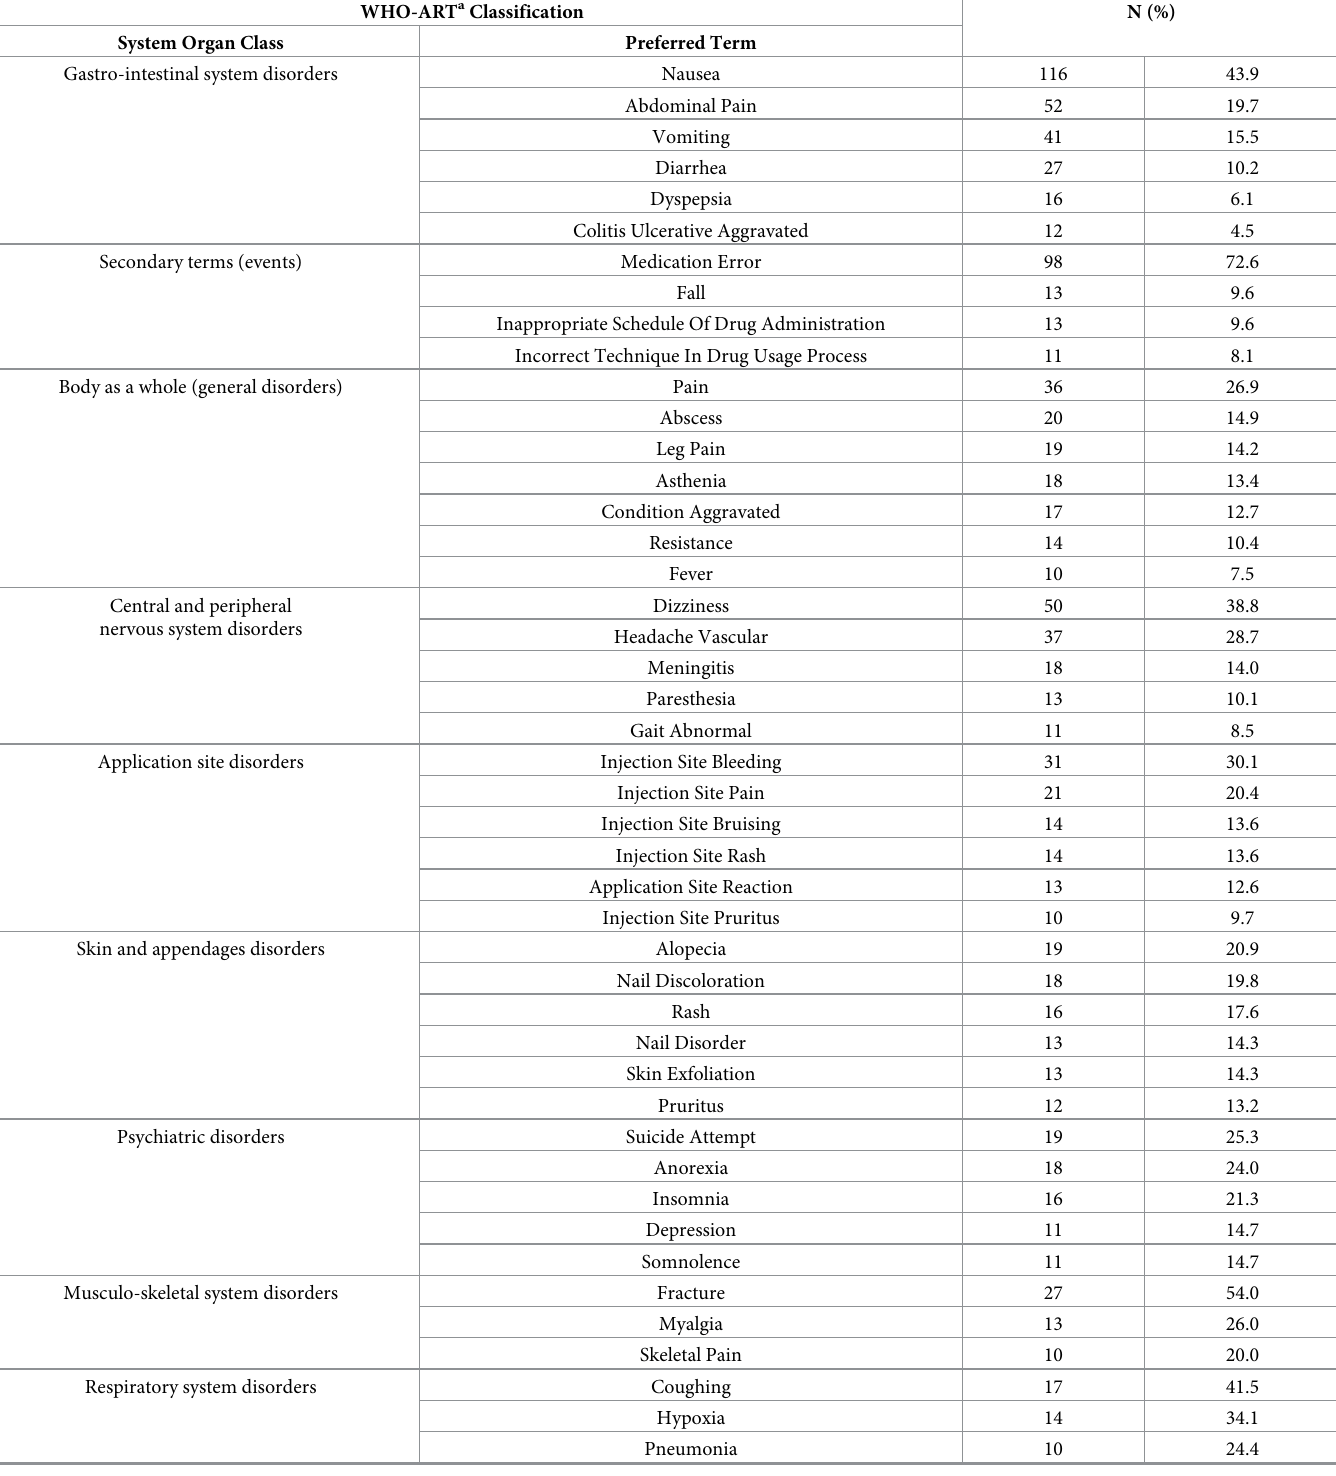
Table 5. Frequency of other ADRs reported together with therapeutic ineffectiveness reports reported in the